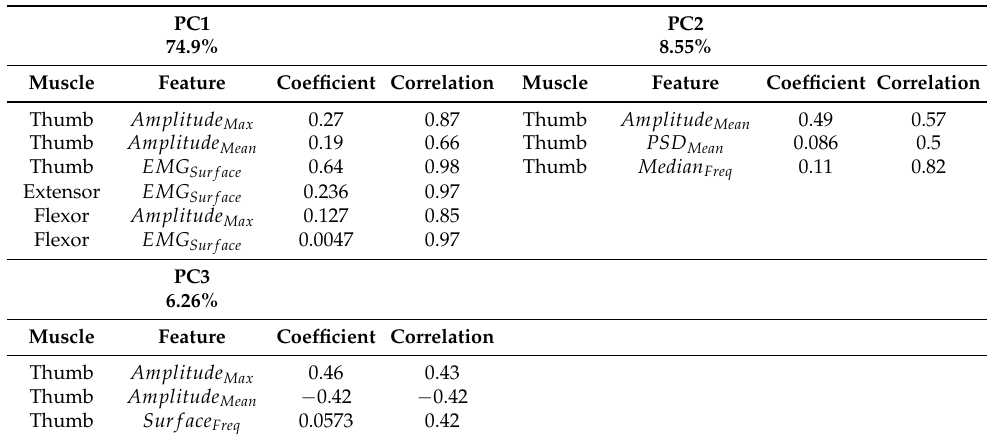
Table 5. PC coefficients and correlations between features and corresponding PC for the second scenario. Only | r | > 0.4 are